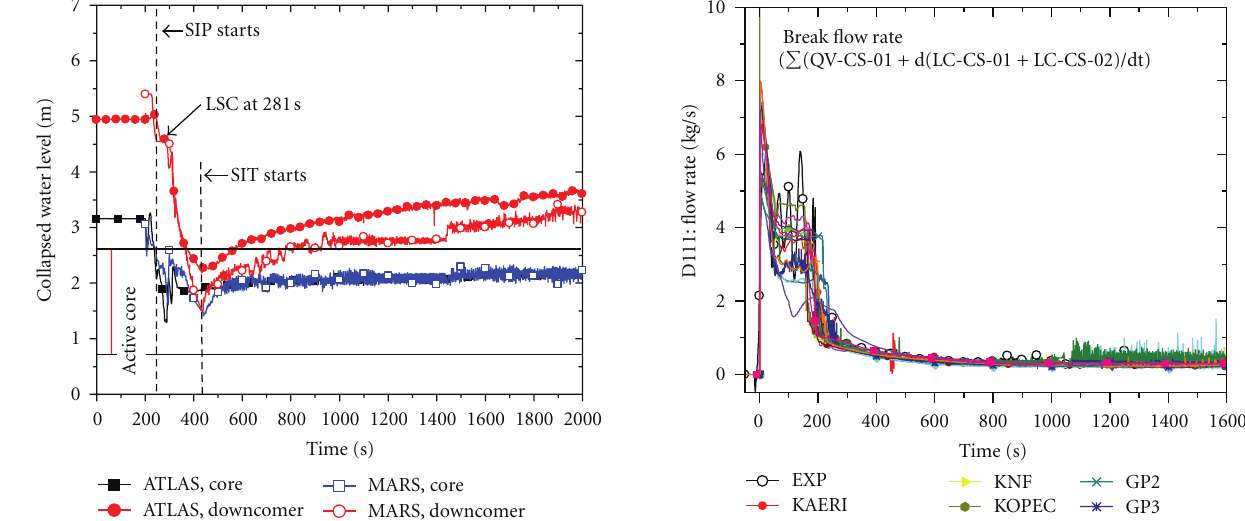
Figure 10: Comparison of collapsed core and downcomer water levels for a 100% DVI line break.